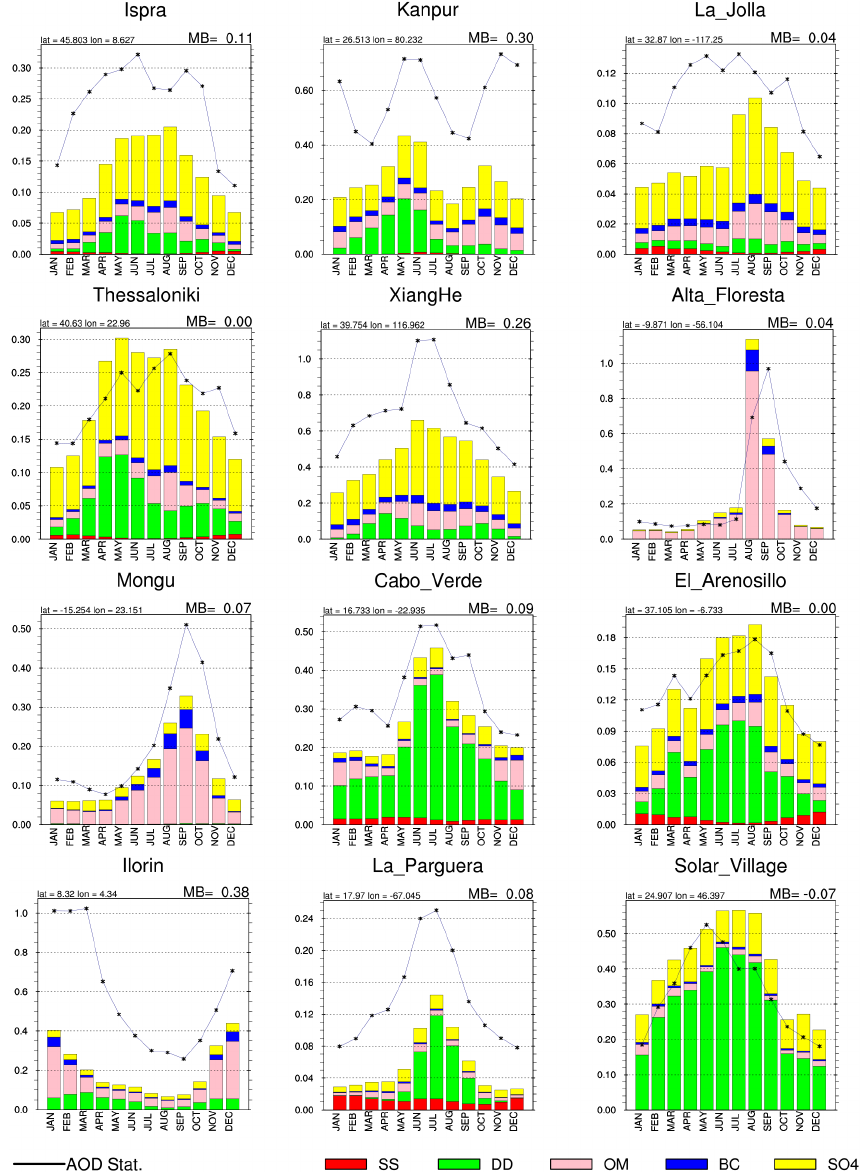
Figure 13. Monthly climatology of AOD, computed from all years of available data, for the AERONET stations of Cesnulyte et al. (2014). Total observed AOD, and SO 4 , BC, OM, DD and SS AODs from the NudSimd2 simulation are displayed.